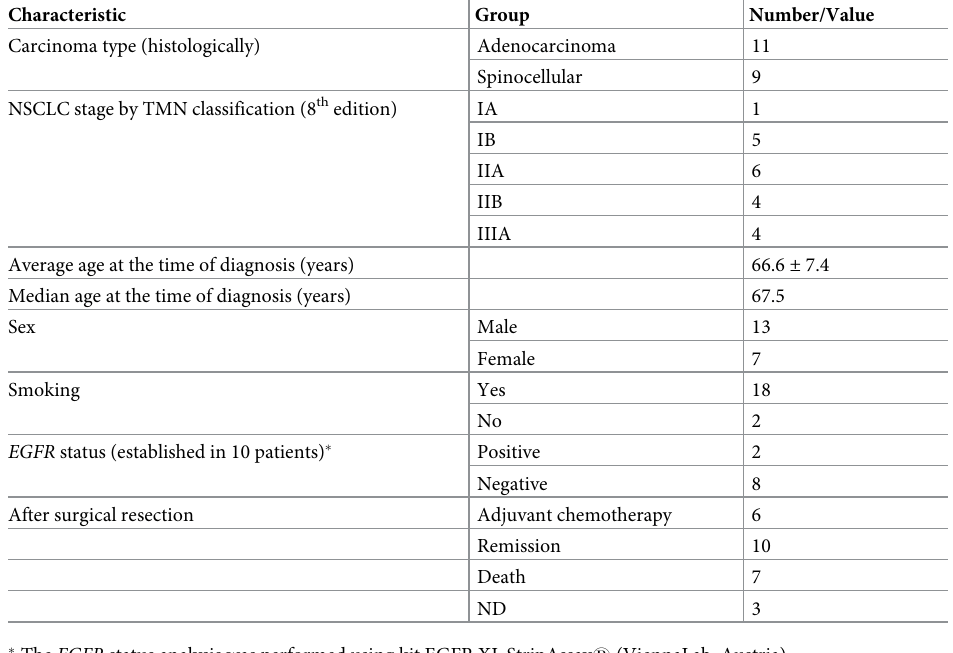
ND—These patients did not continue at follow-up after the surgery in our